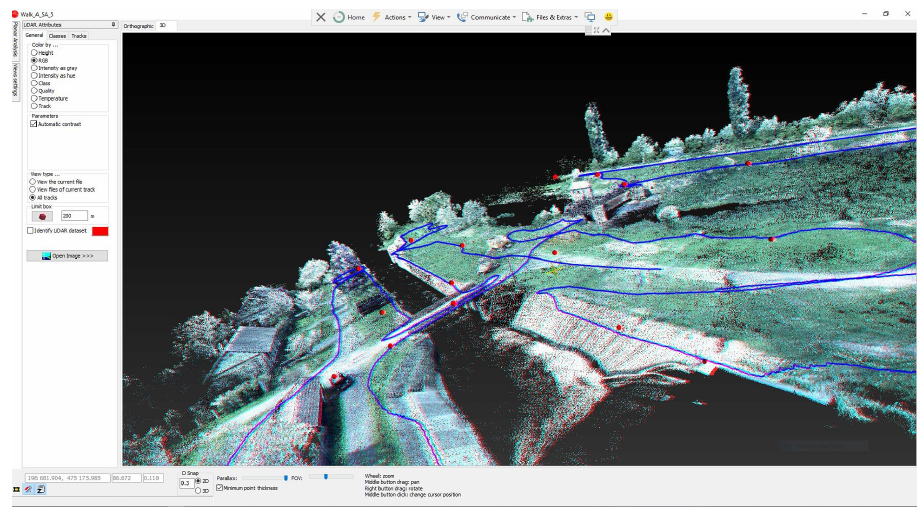
Figure 27. Parallax for viewing using a stereoscopic monitor.